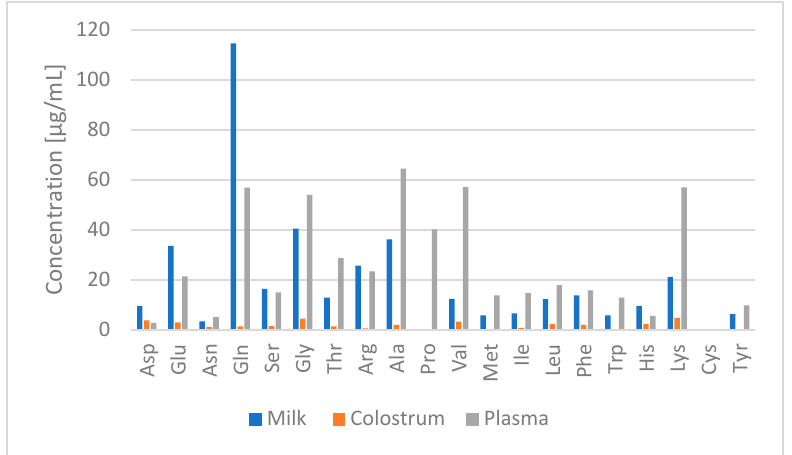
Figure 3. Concentrations of free AAs in plasma, colostrum and milk. The data are the mean of three replicated experiments (CV% ≤ 9.5).